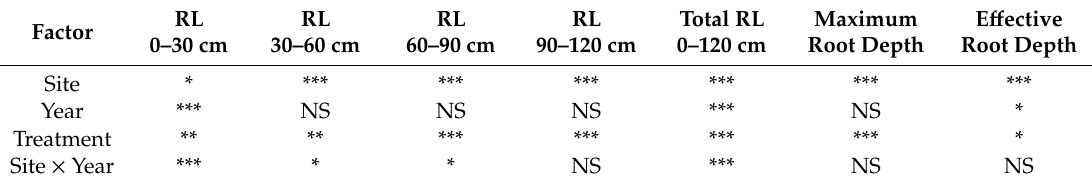
Table 2. Statistical analysis of the e ff ects of the site ( ˇC á slav, Ivanovice, and Lukavec), year (2014, 2015, and 2016), and treatment (N0, MIN, and ORG) factors on the root lengths (RLs) and the maximum and e ff ective depths using analysis of variance (ANOVA).